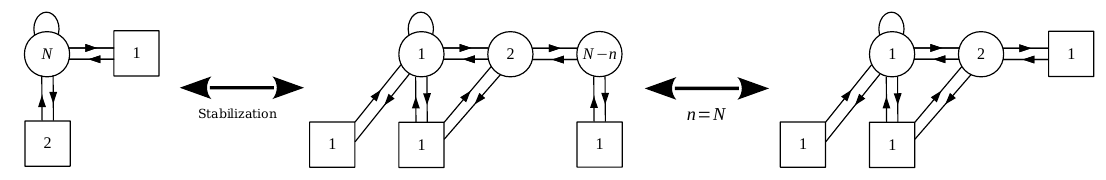
Figure 5 . Sketch of the derivation of the rank stabilization duality in the k = 2 case. In the middle we have the stable con(cid:12)guration.